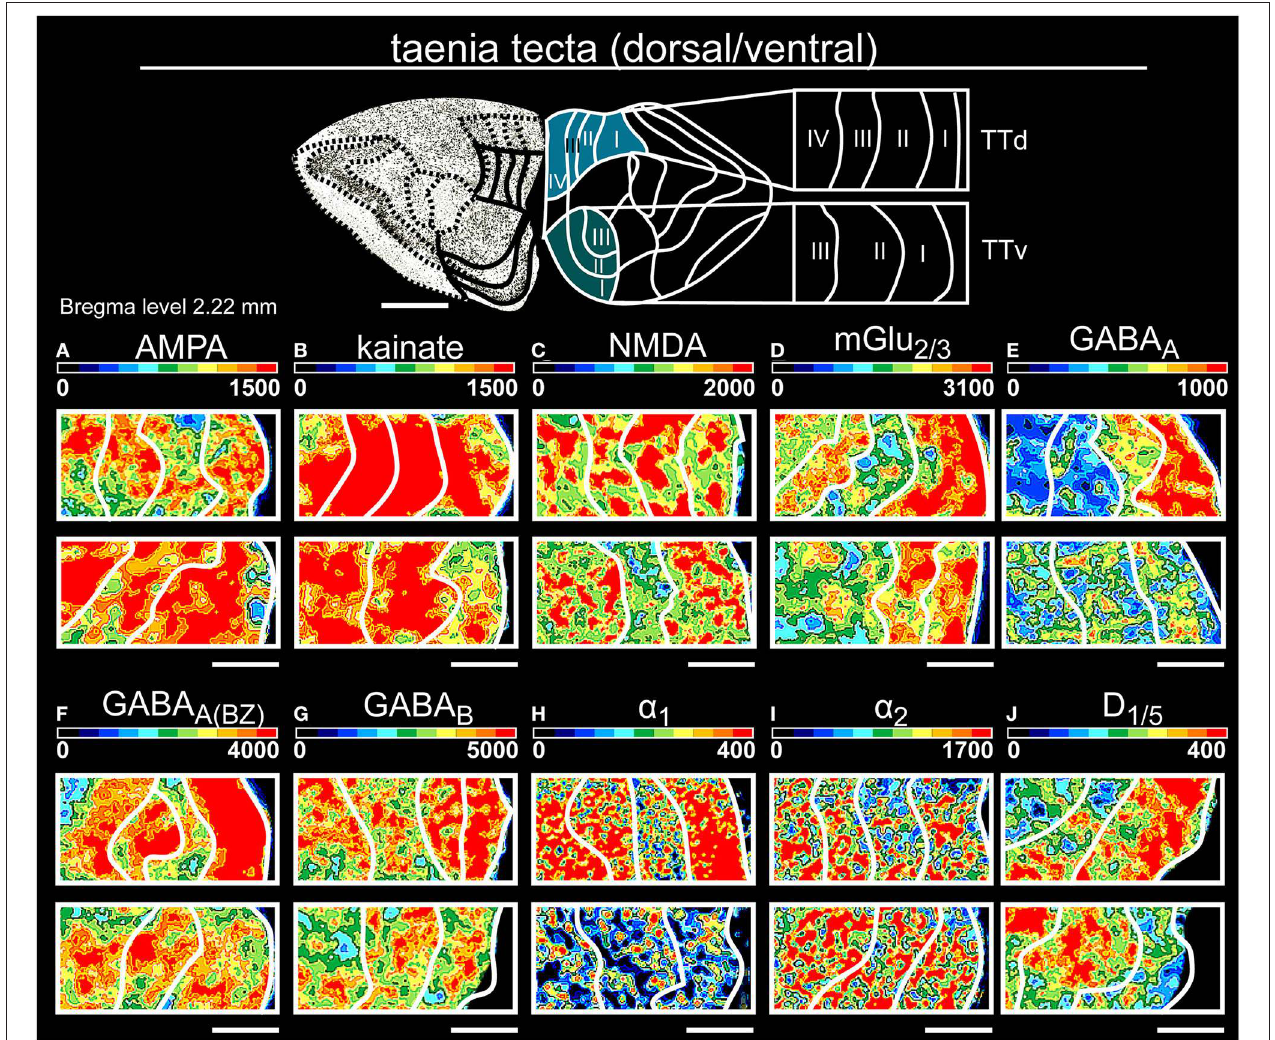
FIGURE 5 | Color-coded autoradiographs showing the distribution and density of all investigated receptors of the taenia tecta (dorsal, ventral). Densities of the color-coded autoradiograms in fmol/mg protein according to color scales. For detailed receptor densities see Table 1 . Scale bars: Atlas, 1mm; (A–J) , 400 µ m; TTd, taenia tecta, dorsal; TTv, taenia tecta, ventral. I, layer 1; II, layer 2; III, layer 3; IV, layer